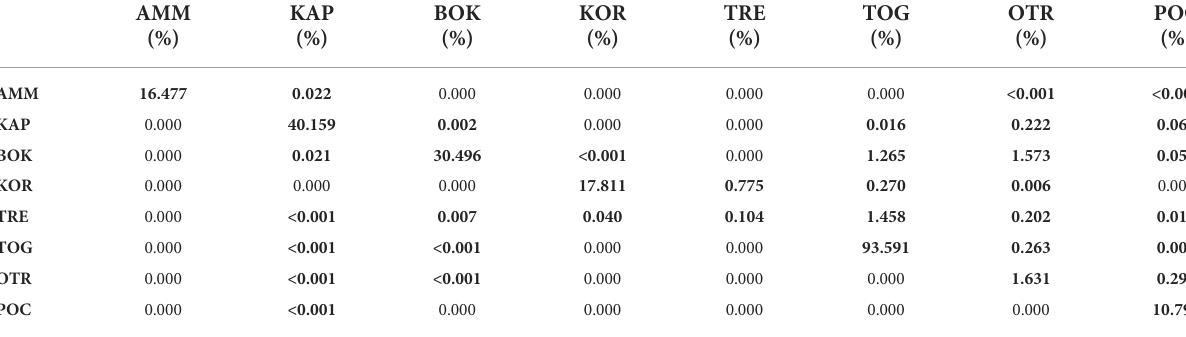
TABLE 6 Connectivity intensity for Pachygrapsus